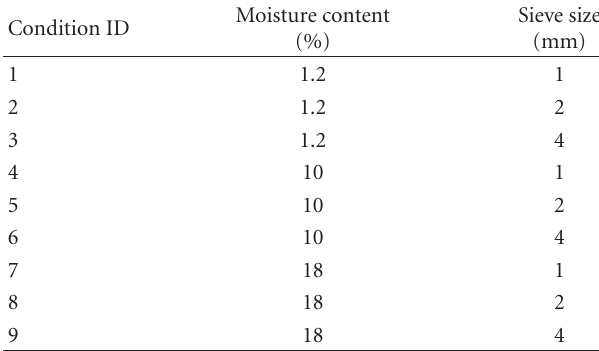
Figure 8: Four steps in sugar yield measurement. Table 1: Experimental